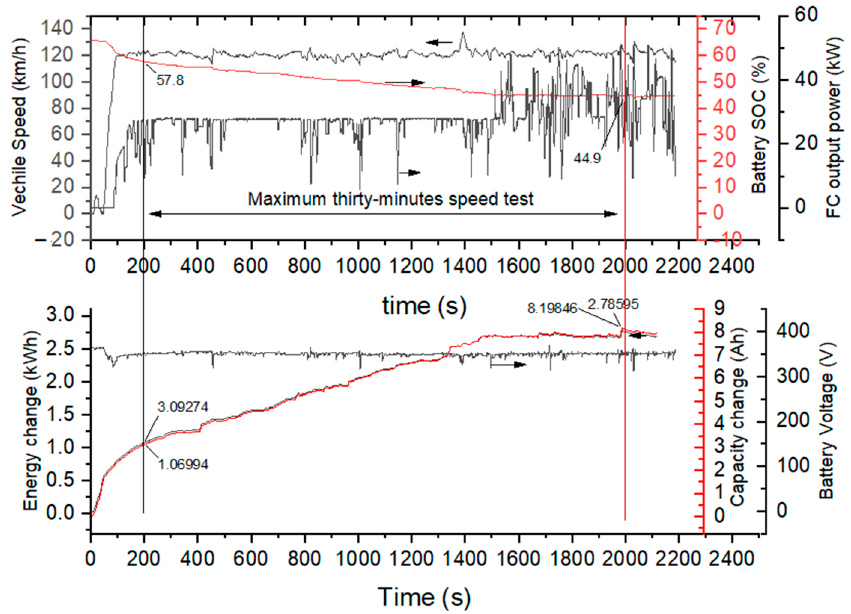
Figure 8. Maximum thirty-min speed test.